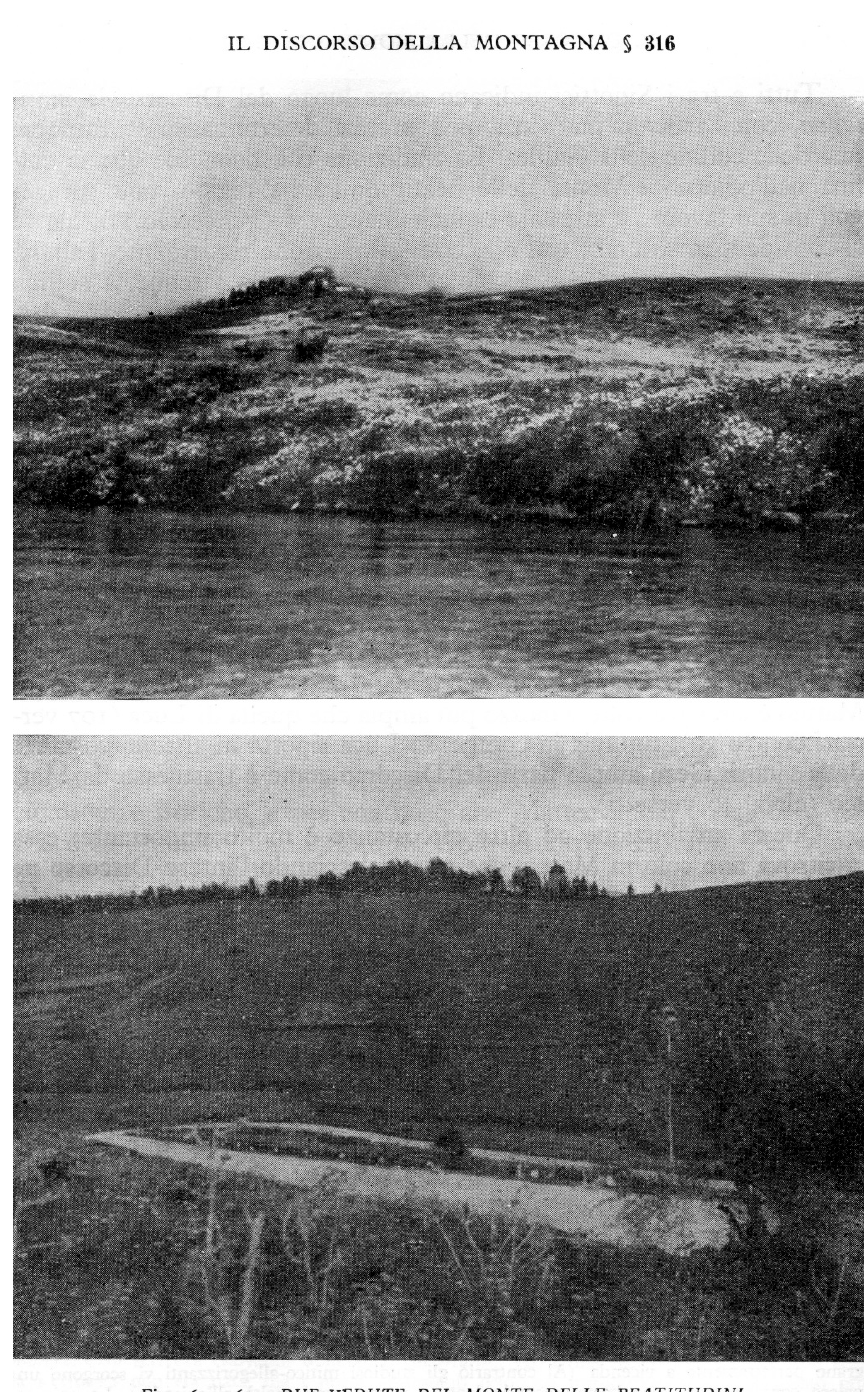
Figure 5. Two views of the Mount of Beatitudes reported in [23], as it appears before 1941. The hill (150 m height above the lake) is near Tabgha, very close to the Lakeshore, 3 km from Capernaum. On top of the hill, there was the Italian hospice for pilgrims, which started its activity in 1925 with Franciscan Nuns. In 1938 the actual Sanctuary was finished, a fact well known in the Italian Catholic Church, and to Maria Valtorta, who used to read newspapers, catholic magazines and listen to the radio, especially to Radio Vaticana. Still today, the Catholic pilgrims are taken to this locality indicated as the “Mount of the Beatitudes”.